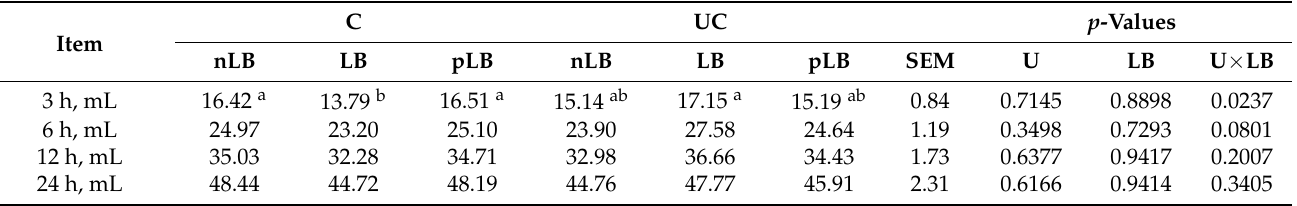
Table 3. Effect of urea treatment and L. buchneri forms on the gas production profile and digestibility parameters of corn